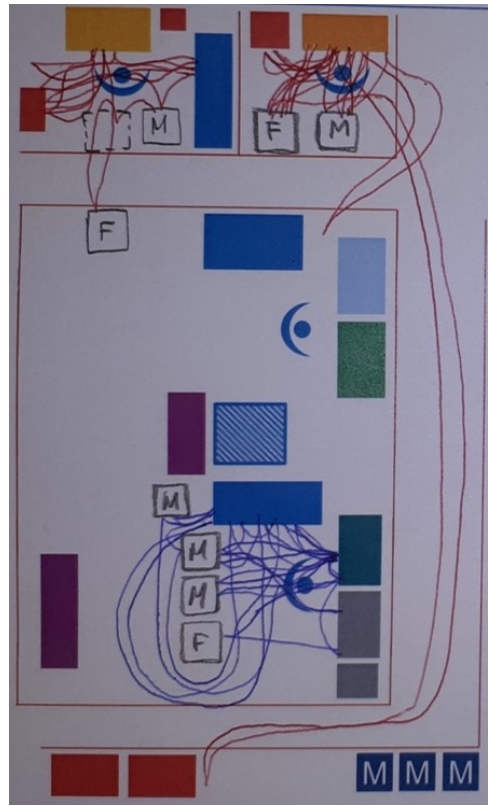
Figure 5. Spaghetti chart (typically